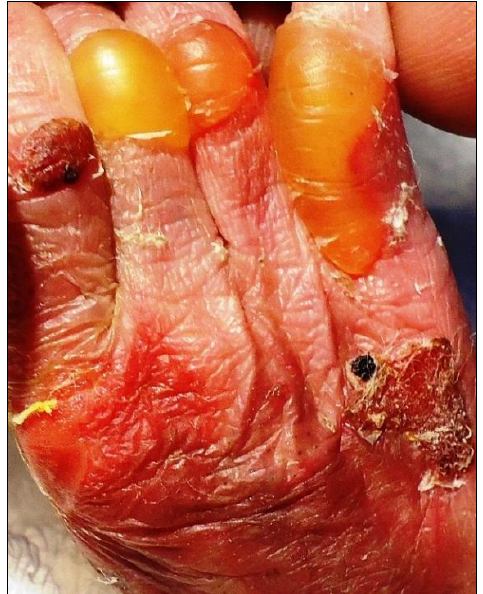
Figure 2: Bullous lesions with skin peel- ing over extremity of